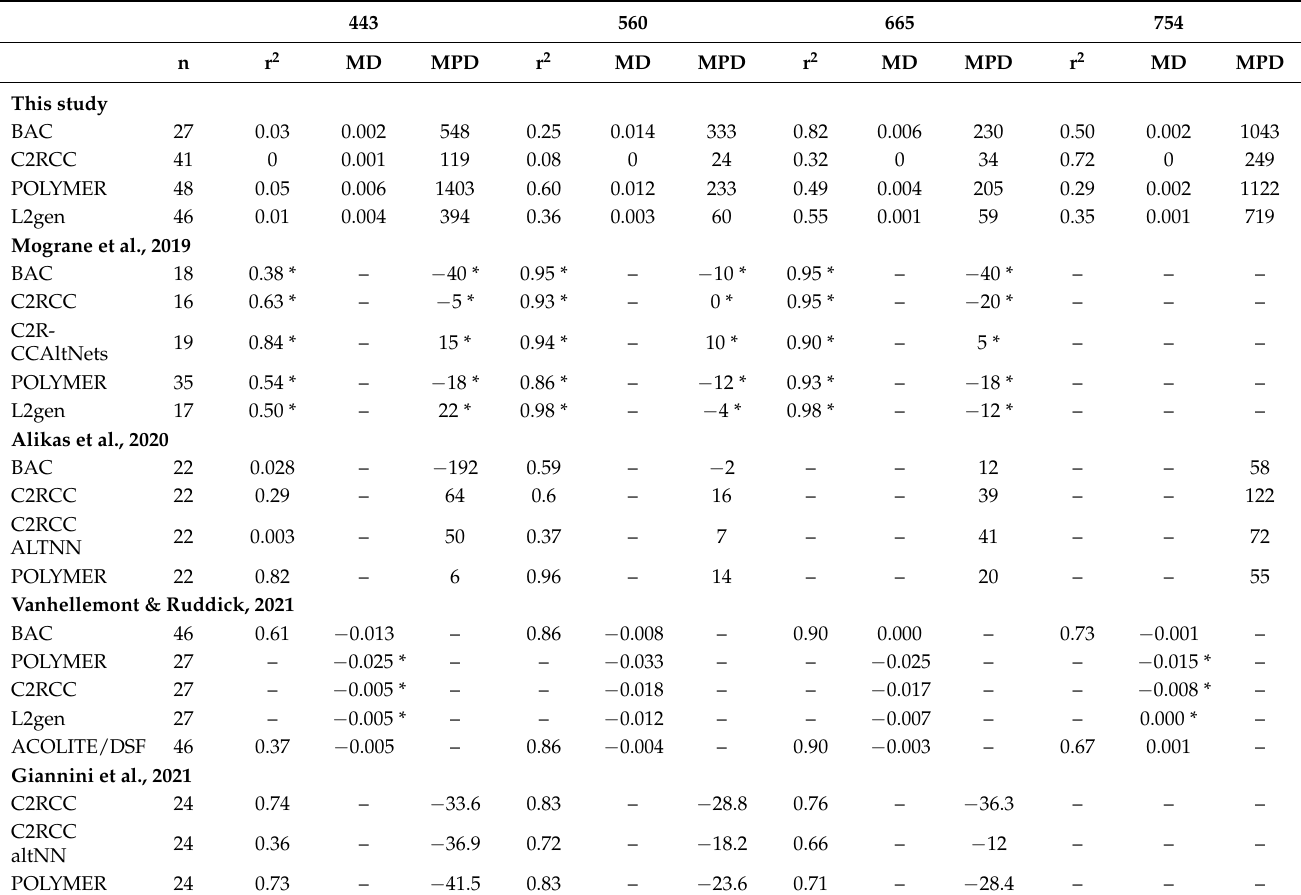
Table 2. Summary of existing OLCI atmospheric correction evaluation literature. Table information includes the atmospheric correction algorithms used, study site, in situ R rs matchup sample size, and performance metric(s) for four wavelengths, if available. BAC: EUMETSAT’s Baseline Atmospheric correction algorithm, C2RCC: EUMETSAT’s Case 2 Regional Coast Color, C2R-CCAltNets: alternative neural nets of C2RCC, POLYMER: POLYnomial based algorithm applied to MERIS, L2gen: NASA’s standard atmospheric correction algorithm, ACOLITE/DSF: ACOLITE atmospheric correction with dark spectrum fitting (DSF). MD: Mean deviation, MPD: Mean Percentage